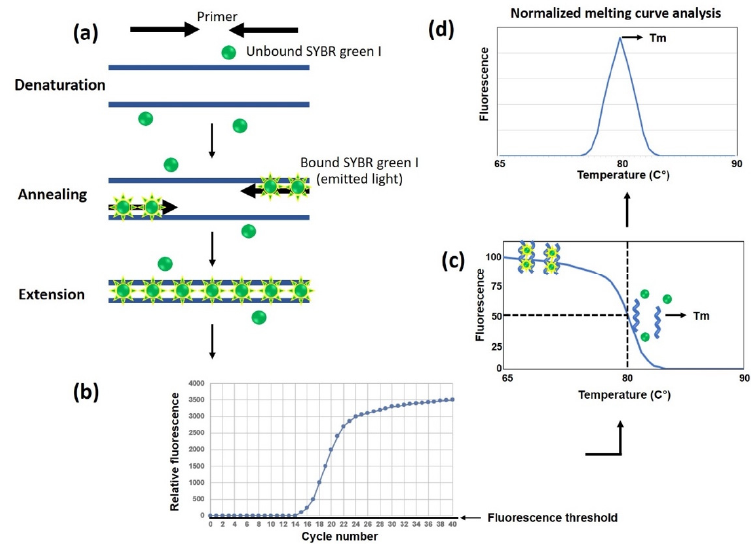
Figure 7. Schematic diagram of a real-time or quantitative PCR (qPCR) and melting curve analysis. ( a ) SYBR green, a non-specific fluorescent dye, binds all double-stranded, but not single-stranded, DNAs and emits a detectable fluorescent signal. Double-stranded DNA products accumulate during repeated thermal cycles, increasing SYBR green fluorescence emission. ( b ) The fluorescent signal in the reaction is proportional to the number of accumulated amplicons, which can be real-time- detected and displayed as an amplification plot. ( c ) When the PCR amplification is complete, a post-PCR dissociation/melting curve of the amplicons is analyzed to assess the assay’s specificity. At the initial phase of the curve, SYBR Green-incorporated double-stranded DNAs appear in a high proportion. An increased temperature denatures or melts the amplicons into single-stranded DNAs, resulting in SYBR Green’s dissociation and a decline in fluorescent signal. ( d ) Based on the obtained data, a normalized melting curve can be generated to show the melting point (T m ) specific to the desired amplicon, wherein 50% of the double-stranded DNAs (primarily amplicons) are denatured. The diagram is adapted from the online reference real-time PCR handbook available online at http://www.gene-quantification.de, accessed on 6 November